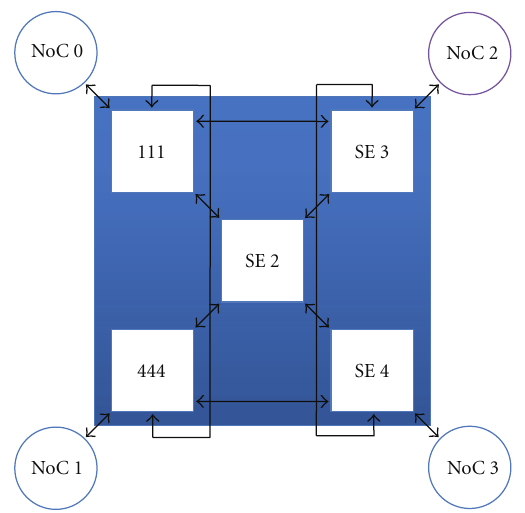
Figure 11: The simulation state of NiP-PNN model at fourth step of best case.